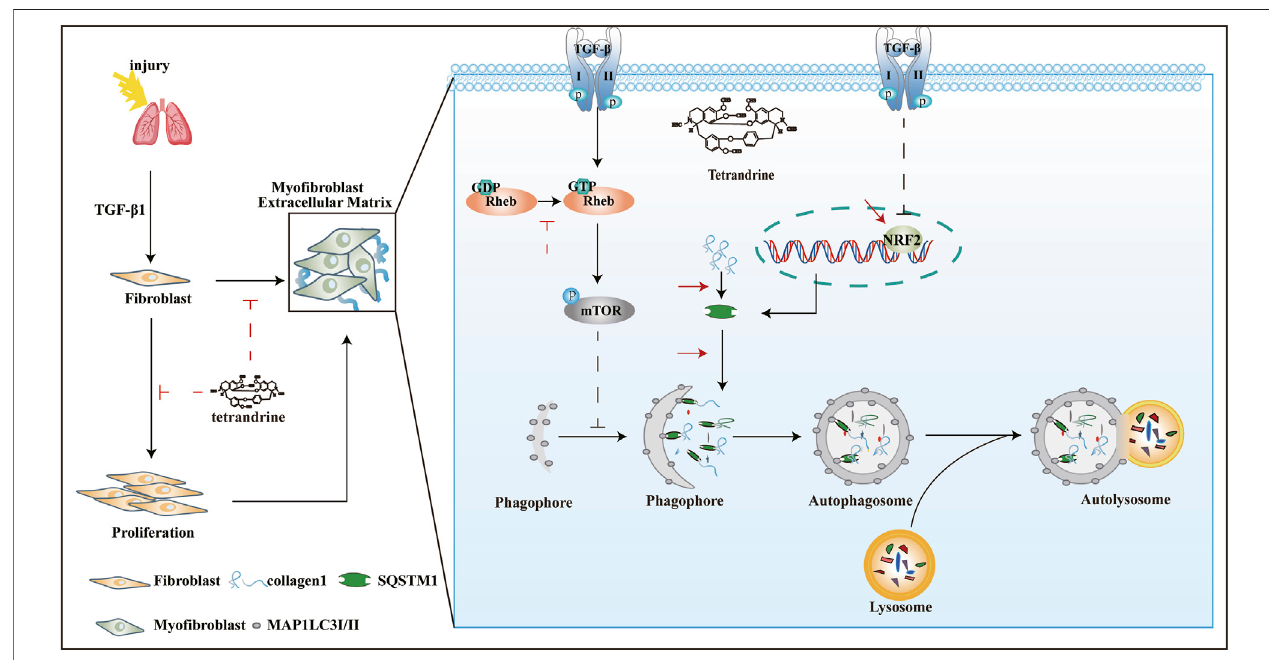
FIGURE 10 | Underlying mechanism of TET against pulmonary fi brosis through SQSTM1-mediated activation of autophagy. See the text for details.